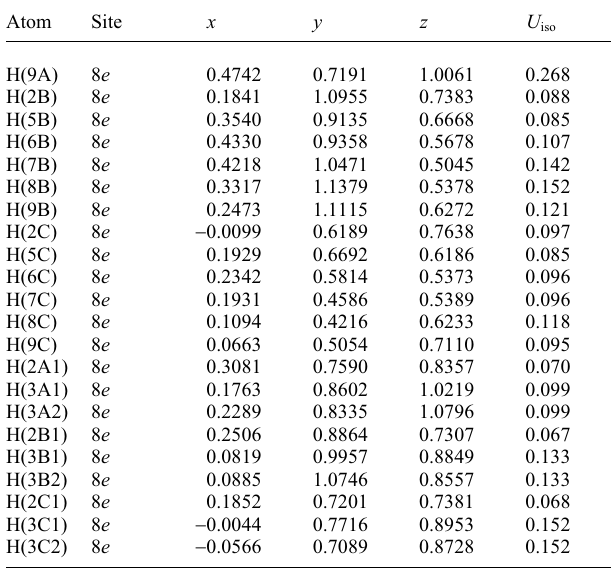
Table 1. Data collection and